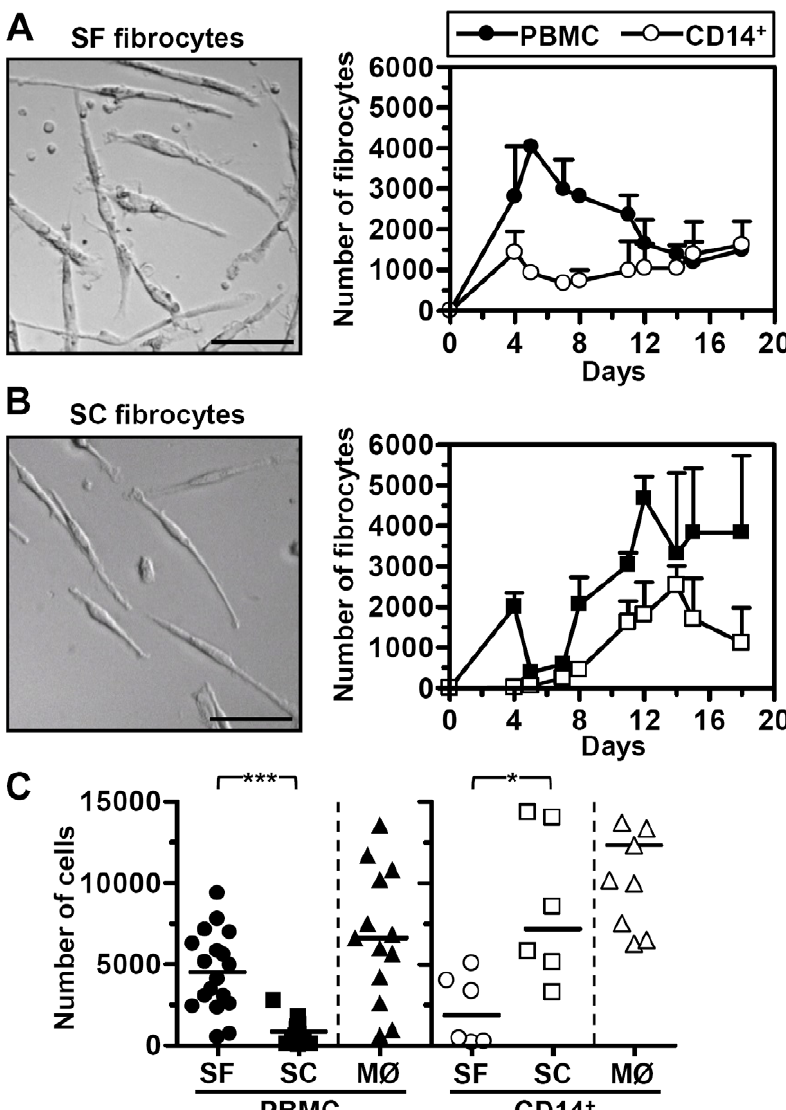
Figure 1. Differential generation of fibrocytes in serum-free or serum-containing conditions, from PBMC and CD14 + monocytes. Fibrocytes were generated from PBMC (filled circles) or purified CD14 + monocytes (open circles) in either serum-free (SF) or serum-containing (SC; 20% HIFCS). The number of fibrocytes is shown during an 18-day culture period (A,B; mean 6 sd of triplicate culture wells). Error bars are only shown in one direction for clarity. Bar represents 50 m m. Fibrocytes and macrophages (MØ) were generated from a number of different normal healthy volunteers (minimum of n=6) and the number of cells per well counted at day 11 of culture (C). *=p , 0.05; ***=p , 0.001; Mann-Whitney test.